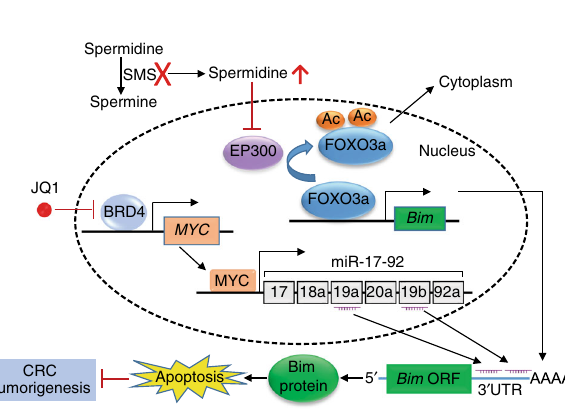
Fig. 8 A model for SMS and MYC cooperation in CRC tumorigenesis. Co- repressing Bim expression by the SMS/spermidine/EP300/FOXO3a and MYC/miR-19a/b signaling pathways is required for maintenances of CRC cell survival and tumor growth. Combined inhibition of both pathways synergistically induces Bim expression and apoptosis, and causes tumor